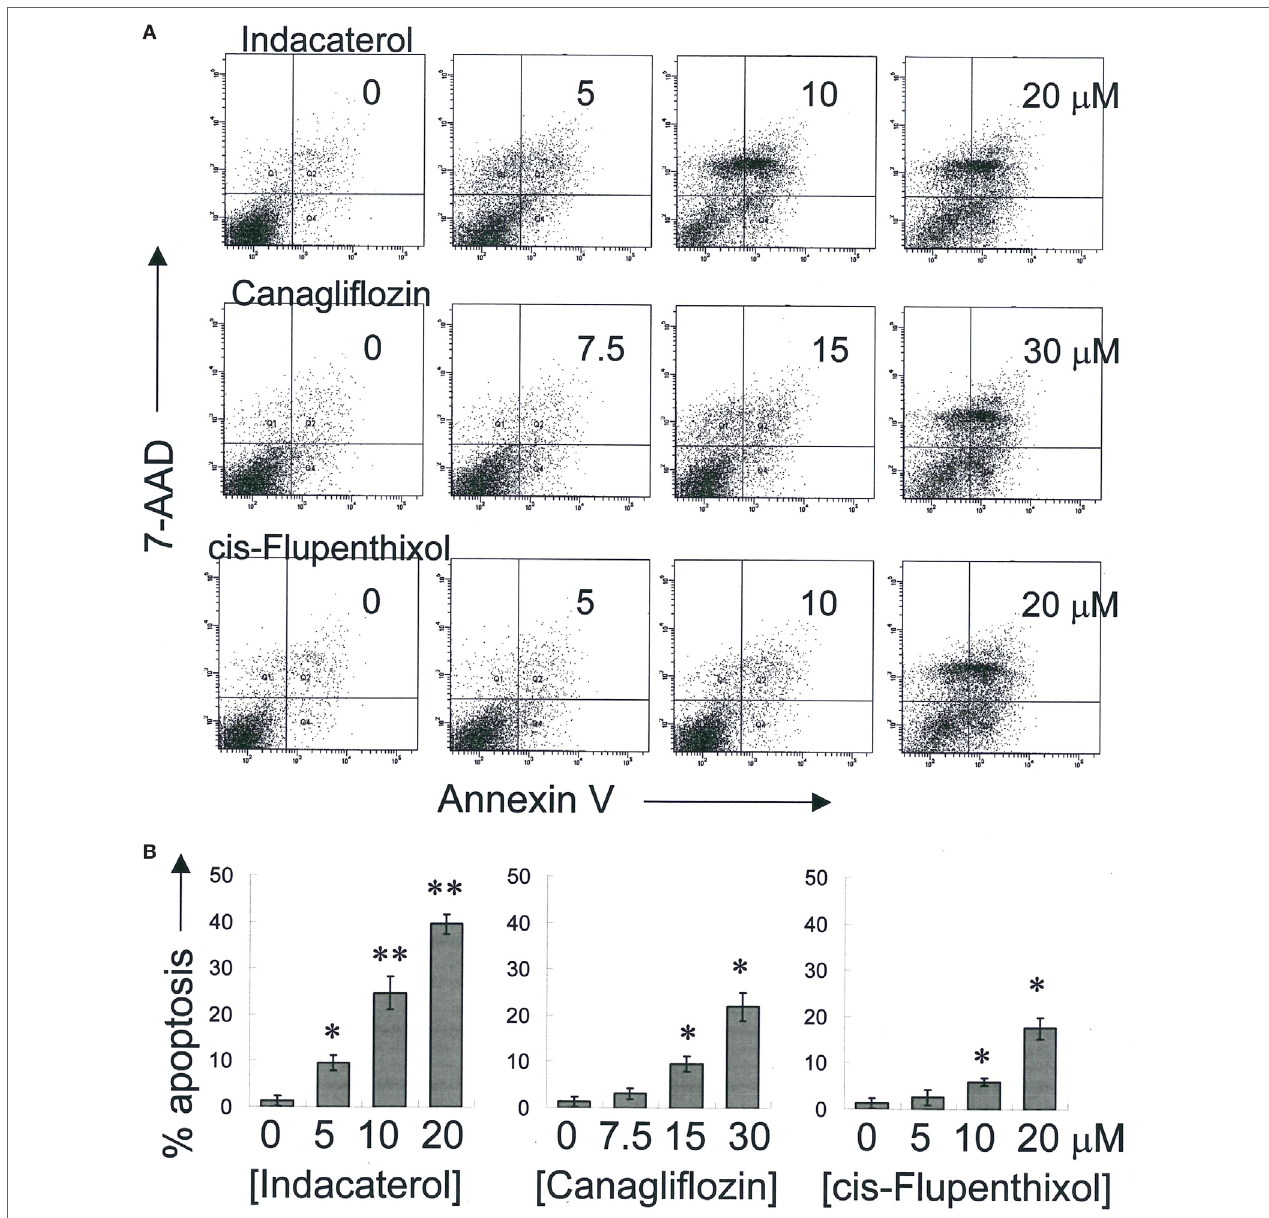
FigUre 3 | Induction of apoptosis by the three positive drug candidates in epidermal growth factor receptor T790M-bearing H1975 cells in a concentration- dependent manner. (a) Cells were exposed to the drugs at the designated concentration for 48 h before harvest for apoptosis assay. A representative set of data from three independent experiments is shown. (b) Summary of apoptosis assay data in (a) from three independent experiments. Data are presented in histogram as mean ± SD. * p < 0.05, ** p < 0.01, Student’s t -test, compared with no treatment